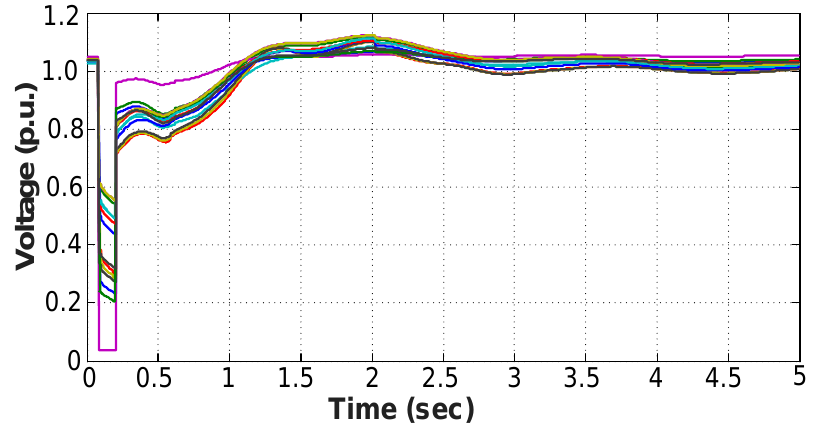
Figure 12. Time-domain simulation of the insecure case with minimum Outlier Index.